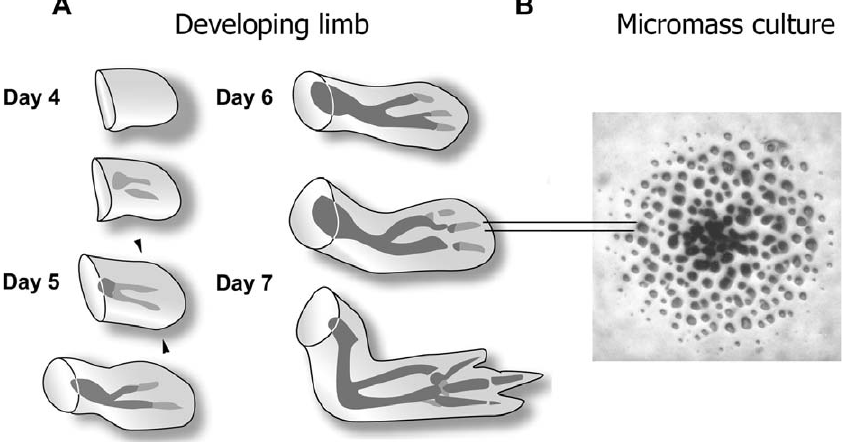
Figure 1. Developing Limb and Micromass Culture (A) Progress of limb skeletal development in chicken forelimb (wing) between 3 and 7 d of embryogenesis. Gray represents precartilage condensation, and black represents definitive cartilage. The developing limb, or limb bud, is paddle-shaped, being flatter in the back-to-front (dorsoventral) dimension than in the thumb-to-little finger (anteroposterior) dimension, or the shoulder-to-fingertips (proximodistal) direction in which it mainly grows. The cartilages that prefigure the bones first arise as stripe-like (e.g., long bones, digits) or spot-like (e.g., wrist bones shown here, or ankle bones in the hindlimb) mesenchymal condensations. The apical zone of the 5-d chicken wing bud (indicated by the arrowheads) or leg bud provide a source of not- yet-condensed mesenchymal cells that when grown in high-density ‘‘ micromass ’’ culture will form precartilage condensations. (B) Discrete spot-like cartilage nodules that have formed after 6 d in a micromass culture of 5-d leg bud apical zone limb mesenchymal cells, visualized by staining with Alcian blue. The cells in these cultures are initially plated as a densely packed monolayer ( ‘‘ micromass ’’ ) and rearrange over short distances in the 2-D plane of the ; 3 mm diameter culture during the indicated period. Each nodule arises from a condensation containing approximately 30–50 cells. As indicated by the parallel lines, the spatial scale of the spot-like nodules (and the precartilage condensations from which they arise) in the micromass cultures is comparable to the diameter of the precartilage and cartilaginous skeletal primordia in the developing limb. The left panel is adapted, with changes, from [54]; the right panel is courtesy of Dr. Sherry